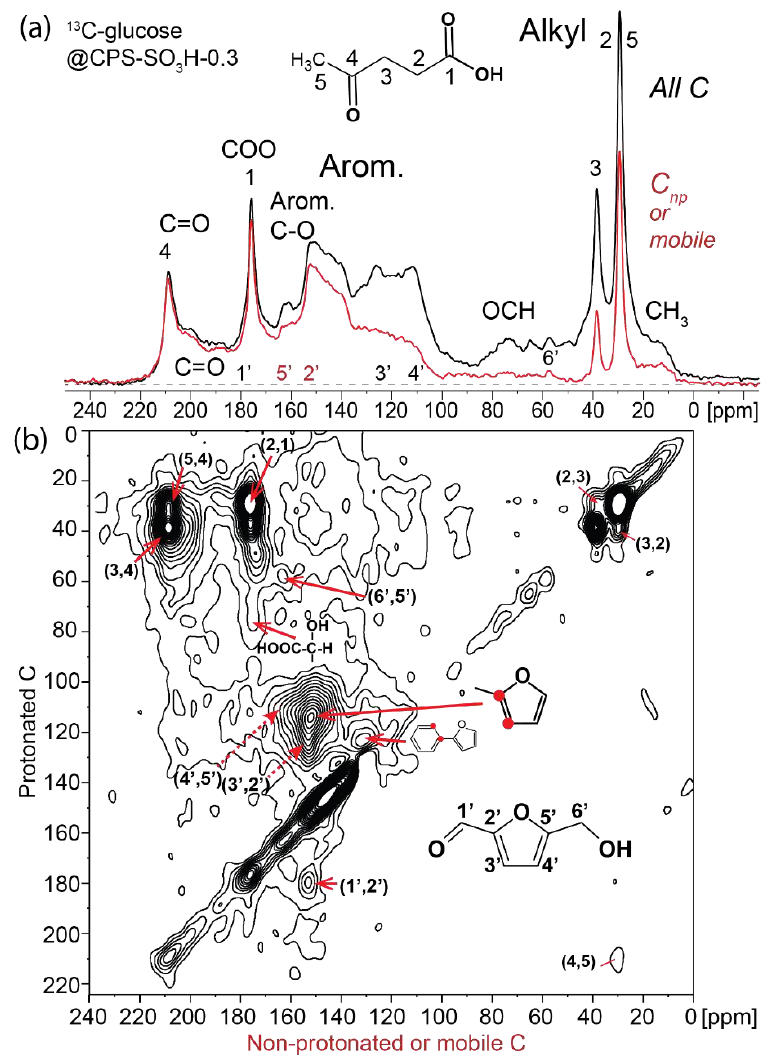
Figure 8. Solid-state 13 C-NMR analysis of CMP-SO 3 H-0.3 after reaction with 13 C-enriched glucose (150 ◦ C, 10 h). ( a ) MultiCP spectra of all C (black line) and of C not bonded to H or in mobile segments (red line). The chemical shifts of levulinic acid (simple numbers) and of HMF (primed numbers) are indicated. ( b ) 2D correlation between protonated and non-protonated or mobile carbons present in the glucose degradation products. Characteristic cross-peaks are labeled.